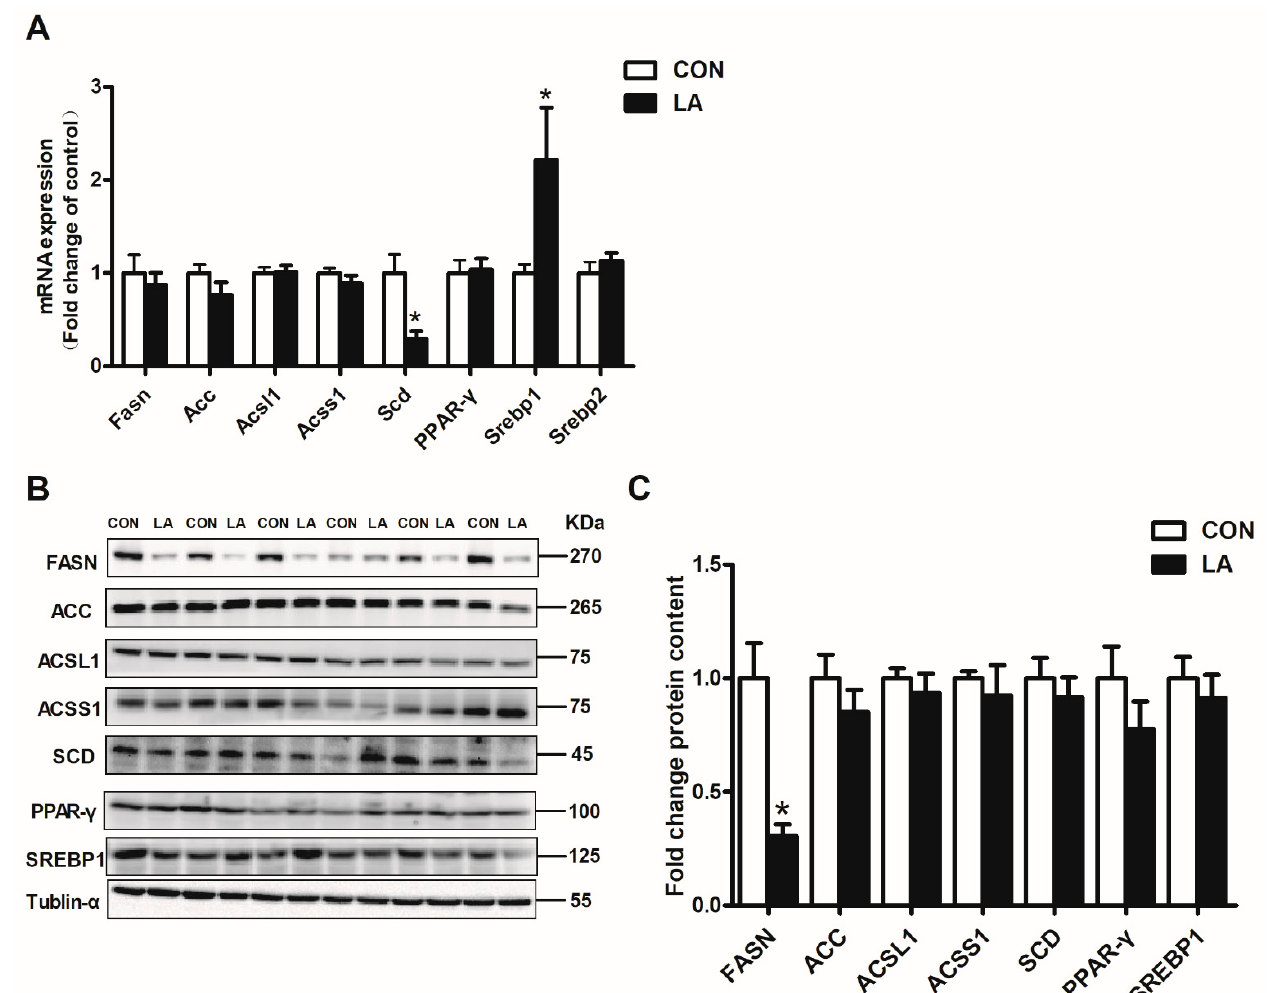
Figure 2. Relative hepatic lipid synthesis gene and protein expression. ( A ) Fasn, Acc, Acsl1, Acss1, Scd, Ppar- γ , Srebp1, and Figure 3. Relative hepatic lipolysis gene and protein expression. ( A ) qRT-PCR analysis of Hsl, Atgl, and Cpt1 α mRNA Srebp2 mRNA expression were evaluated by qRT-PCR. ( B ) Western blot analyses of FASN, ACC, ACSL1, ACSS1, SCD, expression. ( B ) HSL, p-HSL, ATGL, CPT1 α , and tubulin- α protein levels were evaluated by Western blotting. ( C ) Densi- PPAR- γ , SREBP1, and tubulin- α proteins. ( C ) Densitometric analysis of FASN, ACC, ACSL1, ACSS1, SCD, PPAR- γ , and tometric analysis of HSL, p-HSL, ATGL, and CPT1- α protein expression. CON: C on trol diet, LA: Control diet+ alpha- SREBP1 protein levels. CON: Control diet, LA: Control diet+ alpha-lipoic acid. Values are expressed as mean ± SEM, n = 6 lipoic acid.Values are expressed as mean ± SEM, n = 6 in each group, * p < 0.05. in each group, * p <